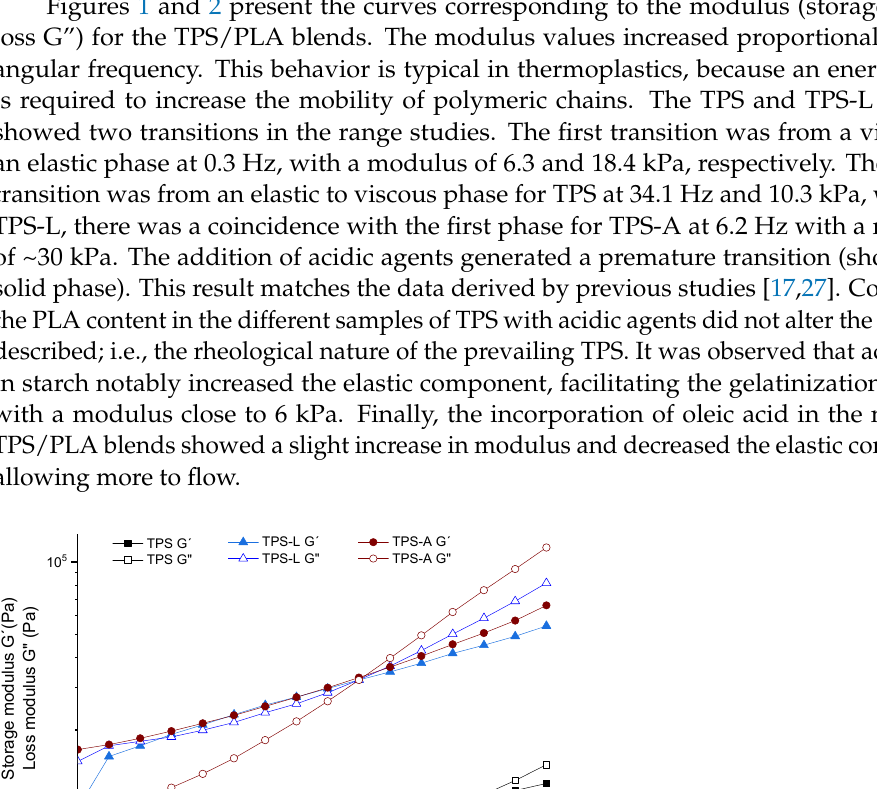
Figure 2. Dynamic rheological properties of TPS and PLA samples. 10 2 10 3 10 4 10 5